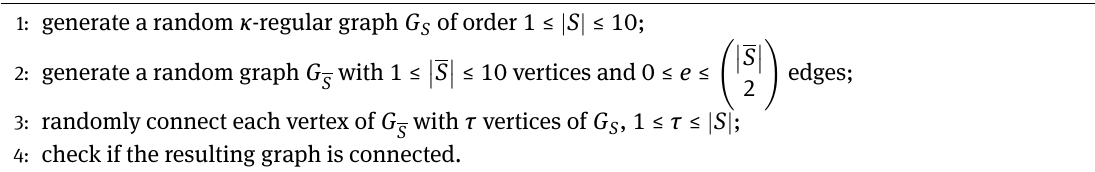
Algorithm 1 (random generation of a graph with a ( κ , τ )-regular set).